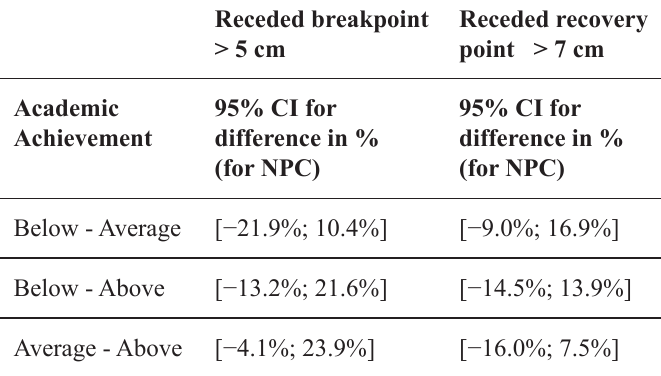
Table 5: Confidence intervals (CI) calculated for the difference in percentages between academic achievement